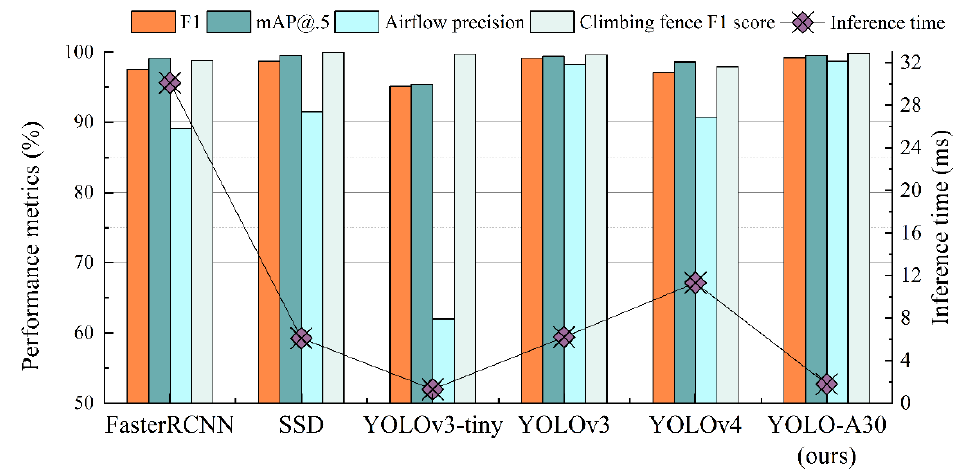
Figure 11. Performance metrics of YOLO-A30 and other SOTA models on focused activities. YOLO-A30 has the highest F1 score of 99.2%, indicating that it can detect the five classes of abnormal vibration activities in the dataset relatively accurately with a low missed-detection rate. F1 scores of YOLOv3 and SSD are only lower than YOLO-A30, each reaching 99.1% and 98.7%, both with excellent performance, but both are more than three times slower than YOLO-A30 in terms of detection speed, which means the longest distance these two models can monitor is much shorter than the monitoring distance of YOLO-A30. Over 95% mAP@0.5 are achieved for all models, with YOLO-A30 and SSD